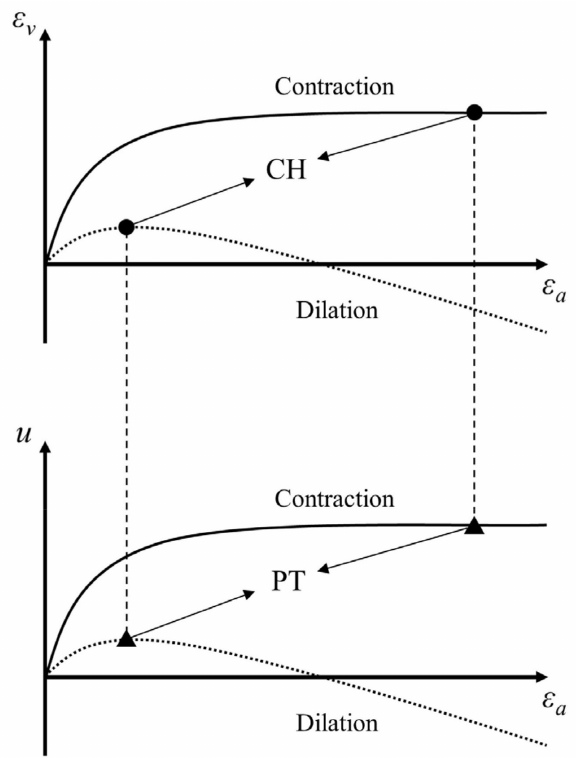
Figure 10. Schematic presentation of characteristic state point and phase transformation point